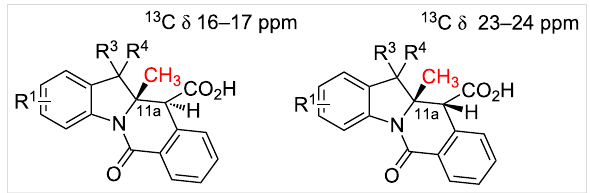
Figure 7: The difference in the 13 C NMR chemical shifts of the angular methyl group between syn - and anti -diastereomers of 11a-Me in com- pounds 10h–k , 10m,n .